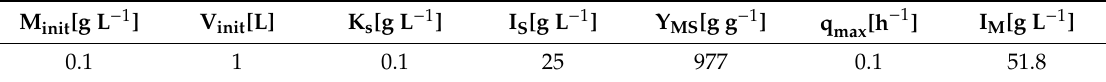
Table A20. Initial concentrations for metabolite M init and volume V init . Model parameters for monod constant substrate K S , substrate inhibition constant I S , yield coe ffi cient metabolite / substrate Y MS , maximum production rate metabolite q max , and metabolite inhibition constant I M . Parameters estimated by adaptation to previous experiment.